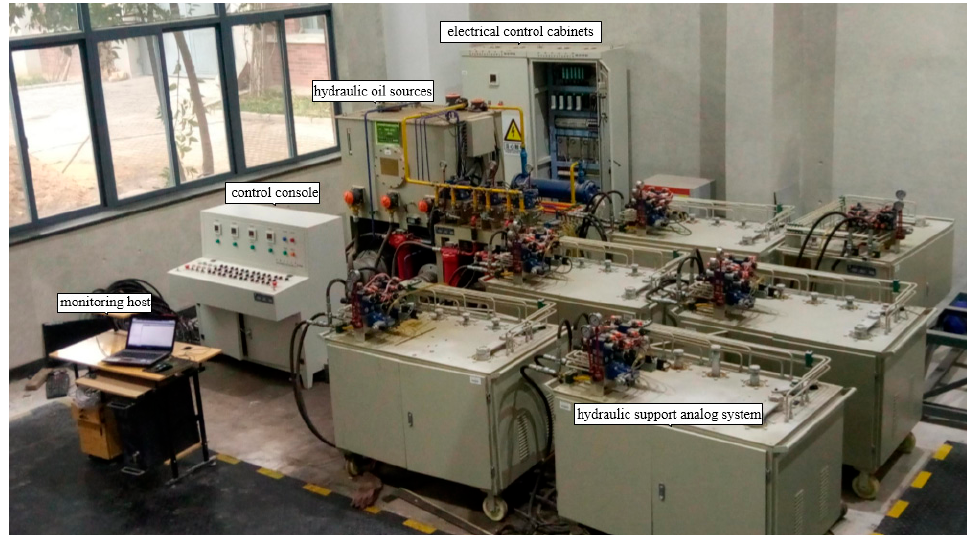
Figure 3. Panorama of the experiment platform.